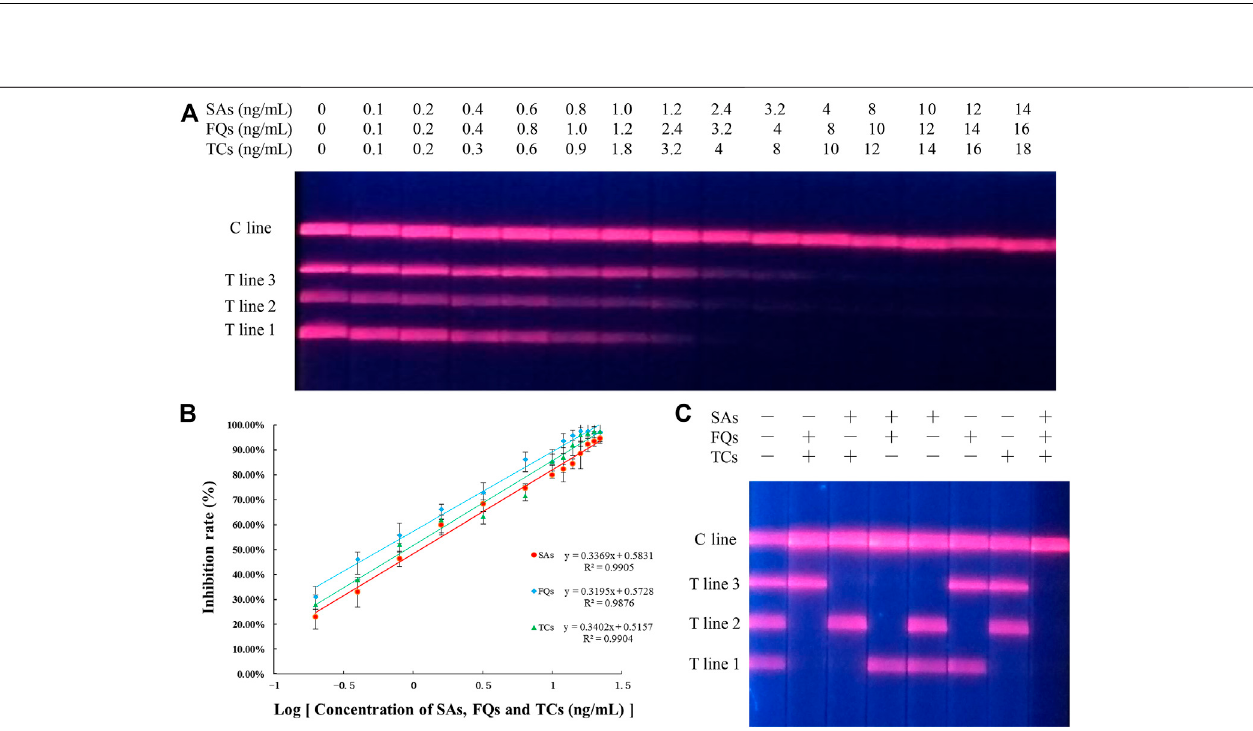
FIGURE 5 | Sensitivity and speci fi city analysis of three-multiple-EuNPs-FIA. (A) Simultaneous sensitivity analysis of SAs, FQs and TCs by three-multiple-EuNPs- FIA. (B) The standard curve for SAs, FQs and TCs by three-multiple-EuNPs-FIA. (C) Speci fi c analysis of three-multiple-EuNPs-FIA.